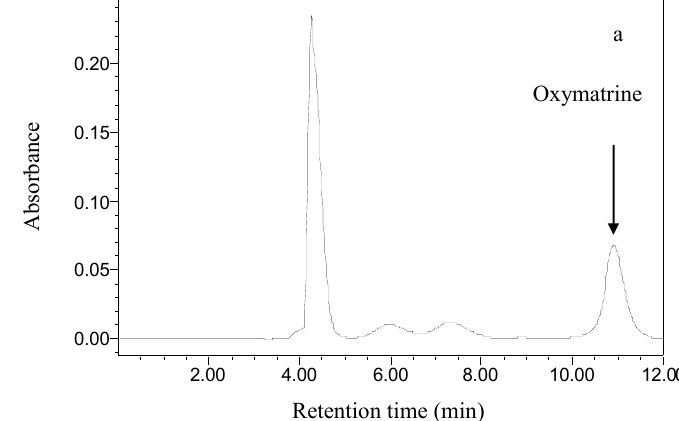
Figure 6. Chromatograms of oxymatrine in standard solution ( a ) and in the sample ( b